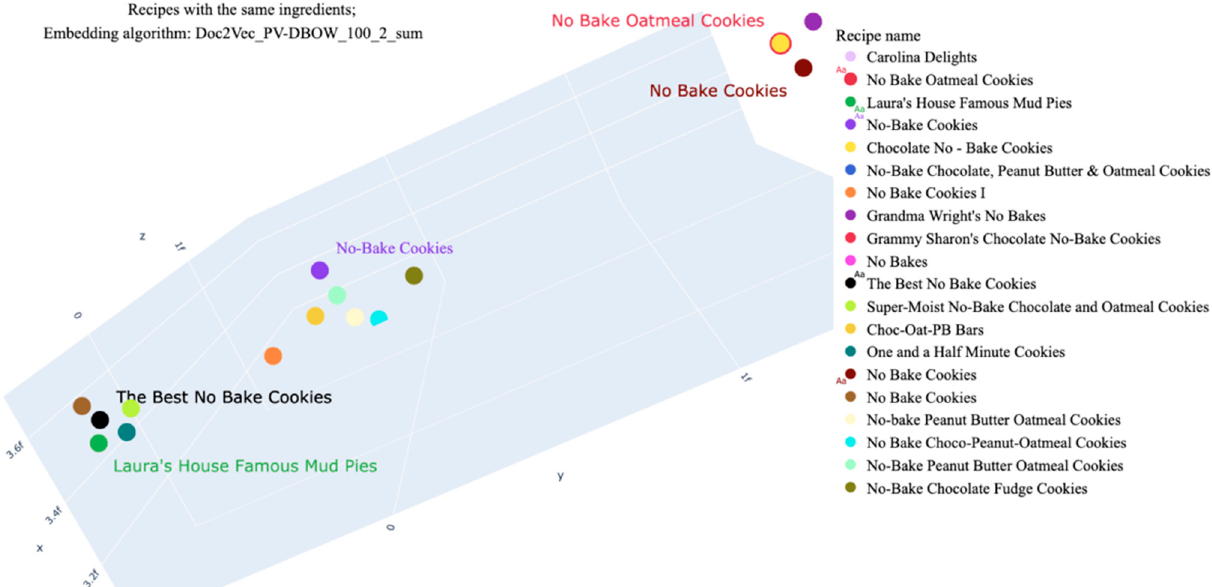
Figure 3. Visual representation of the vector representations without the domain-specific heuristic of a group of recipes with the same ingredients.